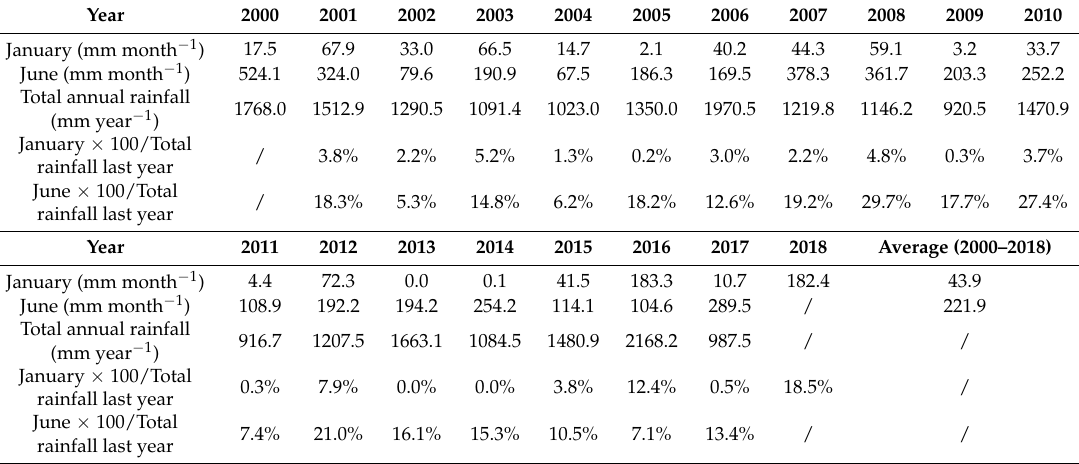
Table A1. Monthly rainfall in Xiamen during 2000–2018